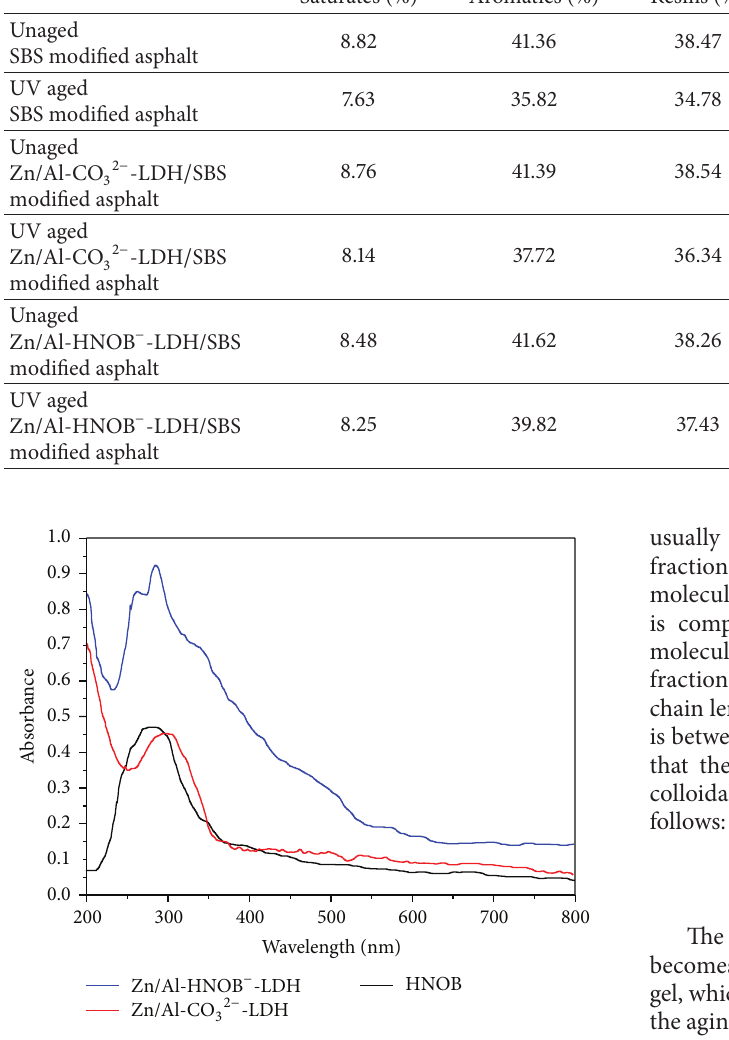
Figure 7: UV-Vis absorbance curves of HNOB, Zn/Al-HNOB − - LDH, and Zn/Al-CO 32−